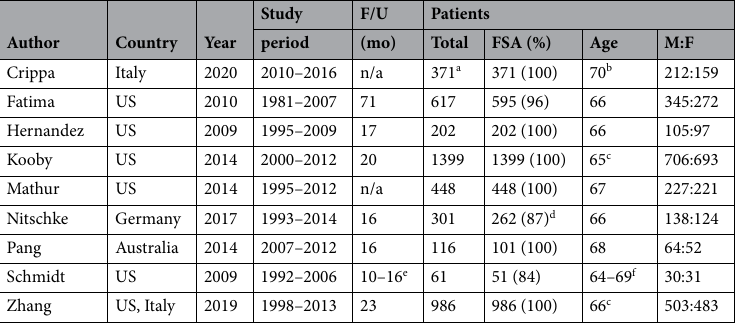
Table 1. Characteristics of included studies. F/U follow up (months), FSA frozen section analysis, M:F male-to-female ratio, n/a data not available. a n = 182 were assessed for comparative frozen section analyses. b n = 244 ≤ 70 years and n = 127 > 70 years. c Values are presented as median. d Secondary data analysis of individual dataset was performed, stratified by pancreatic ductal adenocarcinoma and pancreatoduodenectomy, patients with R2/Rx or no data for frozen section analyses were excluded as described in the original article. e 10 months F/U in the R1R1 group, 16 months F/U in the R1R0 group. f Mean age 69 years in the R1R1 group, 64 years in R1R0